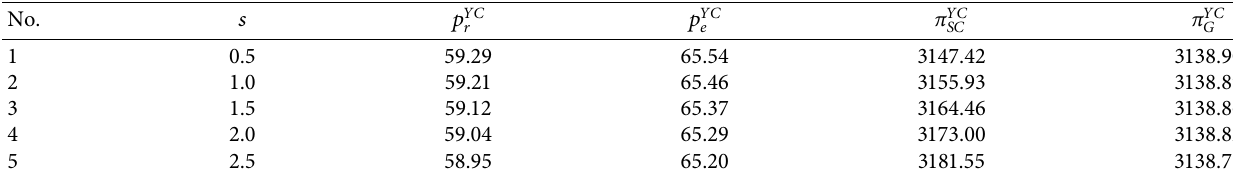
Table 4: The effect of the government’s subsidy coefficient s based on centralized